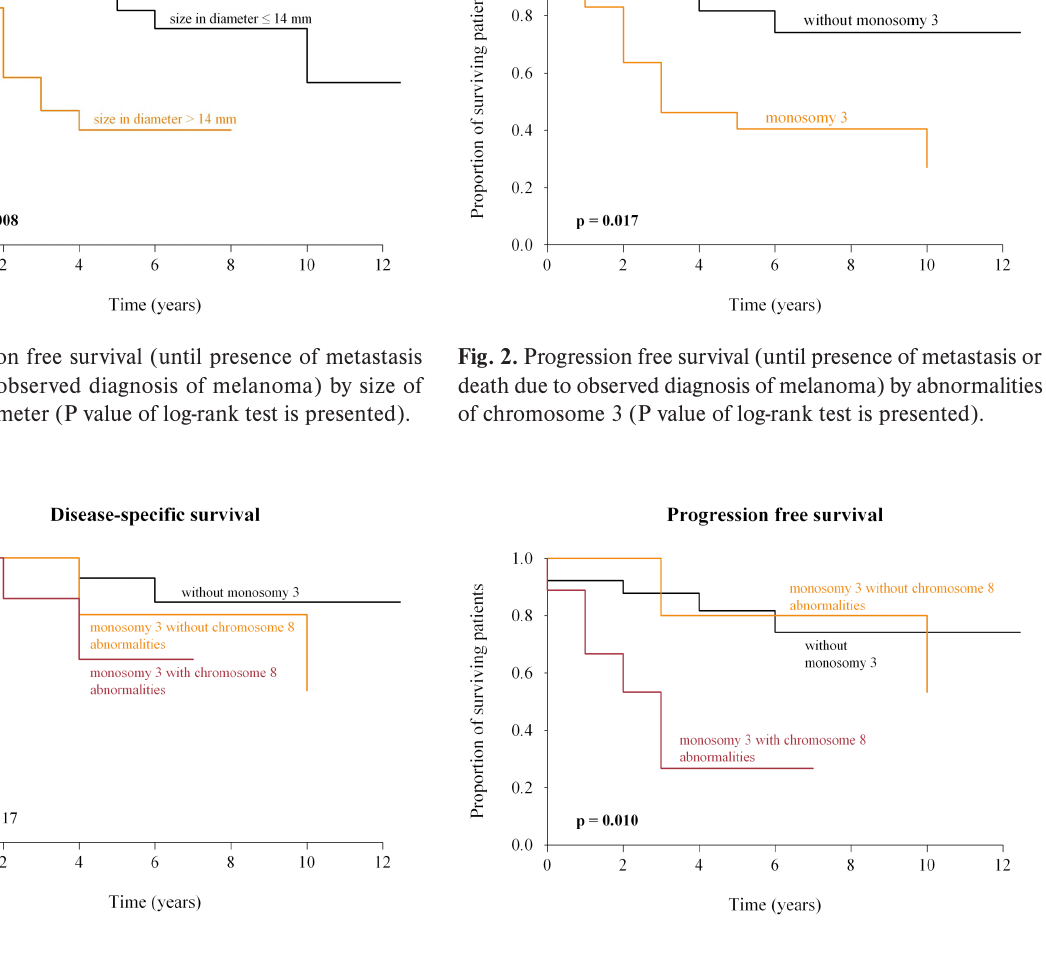
Fig. 4. Progression free survival (until presence of metastasis or death due to observed diagnosis of melanoma) by abnormalities of chromosome 3 and 8 (P value of log-rank test is